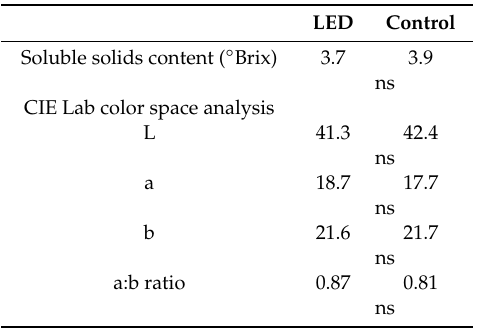
Table 4. E ff ect of lighting regime on fruit soluble solids content and CIE Lab color space